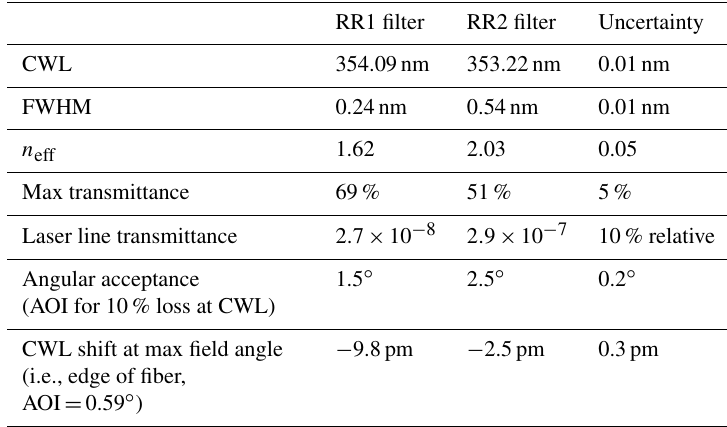
Table 3. Measured RR IF characteristics. All CWL values are given in